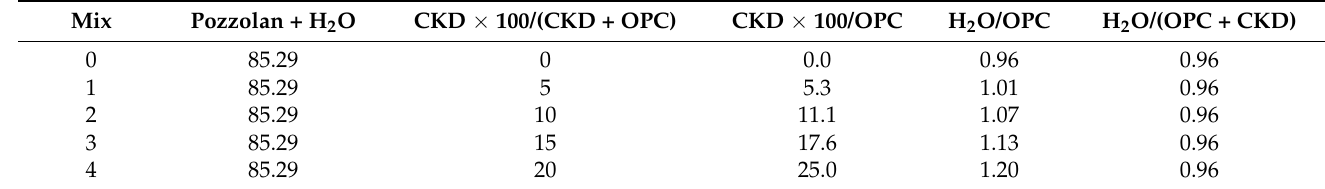
Table 6. Parameters for each of the five test